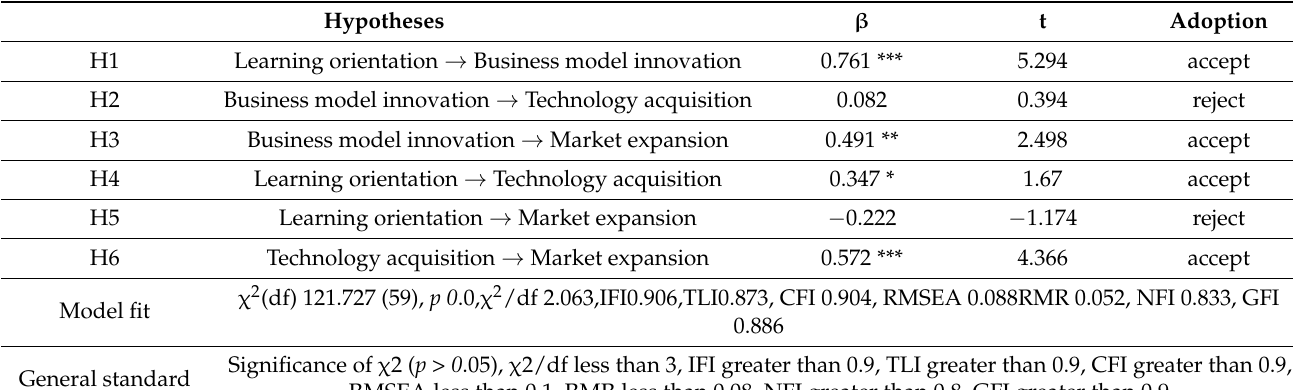
Table 5. Results of hypothesis test.